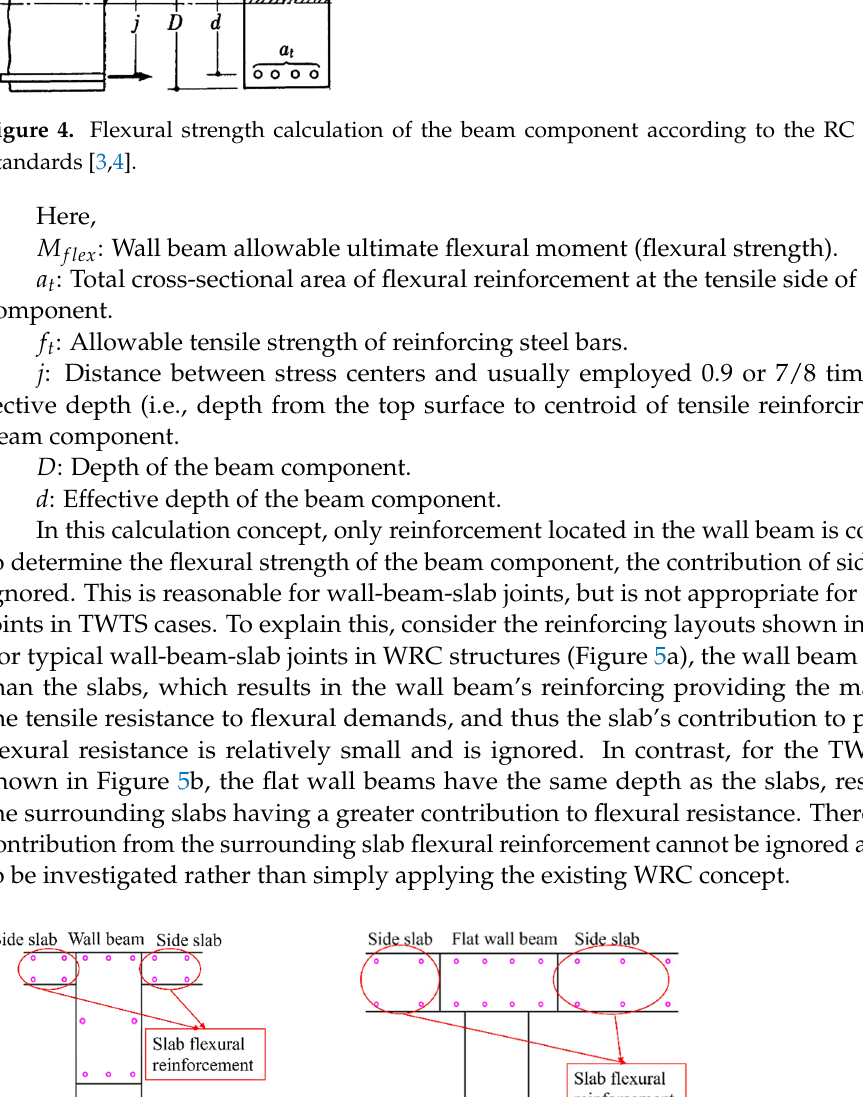
Figure 4. Flexural strength calculation of the beam component according to the RC and WRC Stand- ards [3,4].